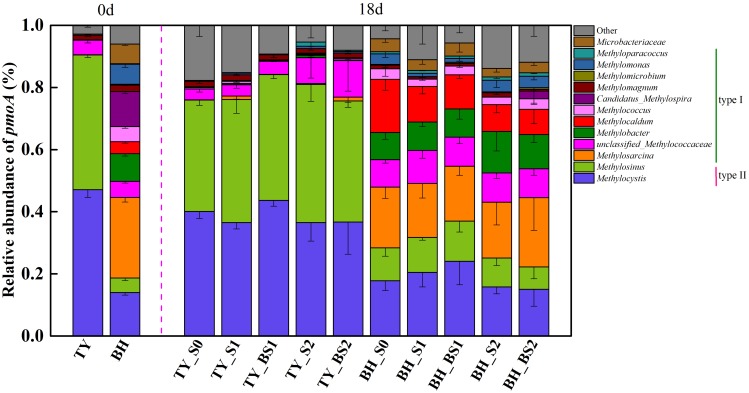
Taxonomic distribution of pmoA-based methanotrophs at the genus level at day 18 during the seedling stage. Other includes the sequences with a relative abundance less than 0.9% and the unclassified sequences at genus level. Mean ± SD, n = 3. 0d represents the original soil used in this experiment.